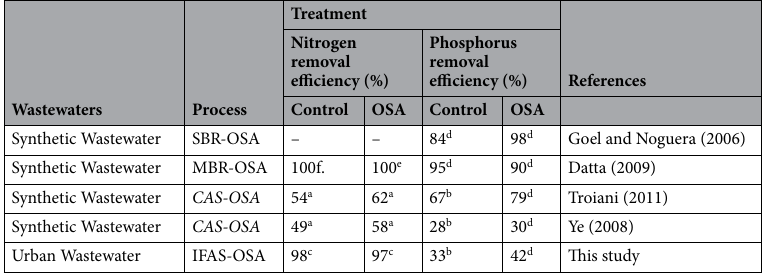
Table 5. The examples of nitrogen and phosphorus removal efficiency reported in the present and previous studies. a: TN removal, b: TP removal, c: NH 4 removal, d: PO 4–3 removal, e: NH 3 removal.